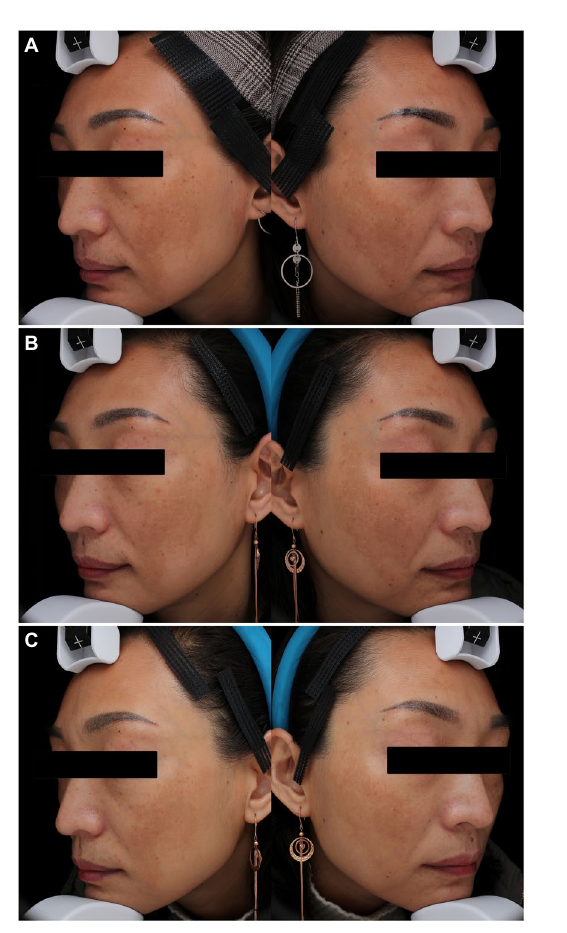
FIGURE 5 Melasma in a 43-year-old woman with Fitzpatrick skin type IV in the PSAL (755 nm) group. (A) At baseline, MASI score = 17.0; (B) one month after three laser treatments (week 12), MASI score = 15.6; (C) 4 months after three laser treatments (week 24), MASI score = 12.4. PSAL, picosecond alexandrite